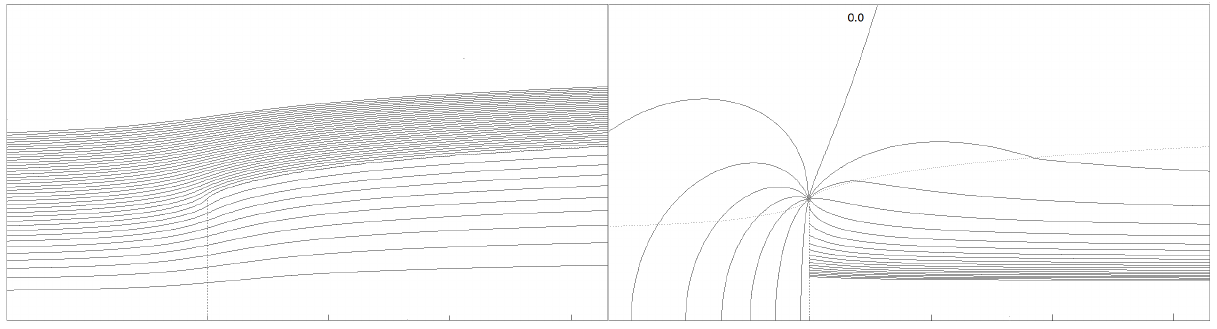
ρU 2 ) = − 0 . 8888 and λ = 1 . 018. Isobars close to 0 2